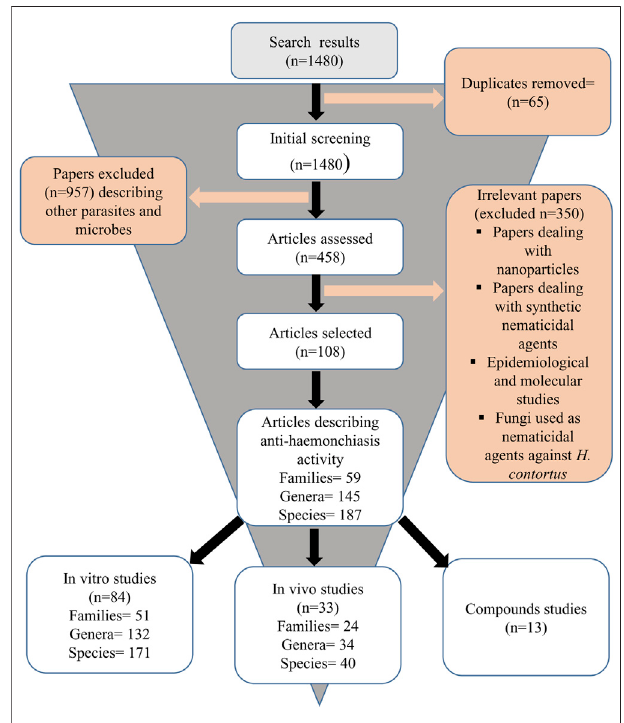
FIGURE 1 | Flow chart of screening process of